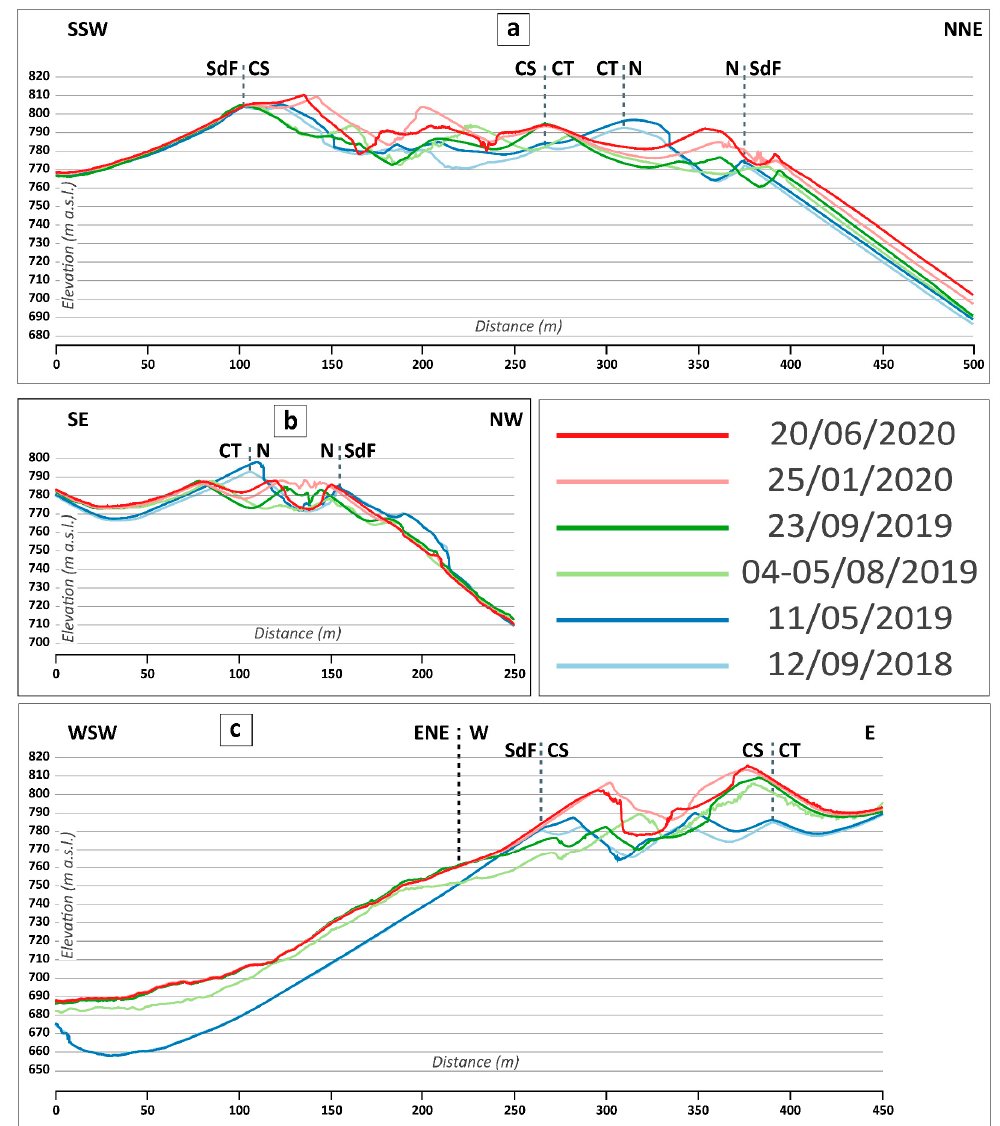
Figure 6. ( a ) Cross-sections of the crater terrace through time (12 September 2018 to 20 June 2020) along profile 1 in Figure 5. ( b ) Cross-sections of the SW crater area and upper SdF through time (12 September 2018 to 20 June 2020) along profile 2 in Figure 5. ( c ) Cross-sections of the lava field and SW crater area through time (12 September 2018 to 20 June 2020) along profile 3 in Figure 5.